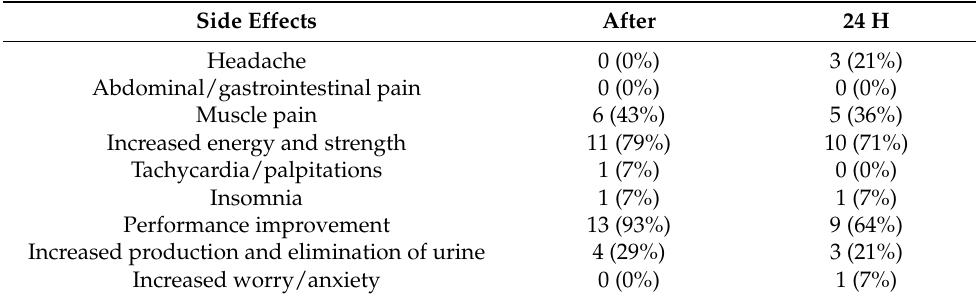
Table 2. All side effects and number (frequency) of participants who reported side effects immedi- ately after the test protocol with CA (Questionnaire of Side Effects (QUEST) + 0 h) and 24 h after (QUEST + 24 h).